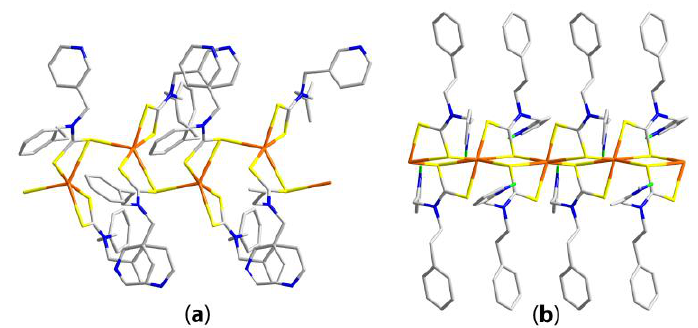
Figure 18. One-dimensional aggregation in ( a ) [Hg{S 2 CN[(CH 2 ) 2 Ph]CH 2 (3-py)} 2 ] n ( 184 ) and ( b ) [Hg{S 2 CN[(CH 2 ) 2 Ph]CH 2 (1H-pyrrol-2-yl)} 2 ] n ( 185 ).